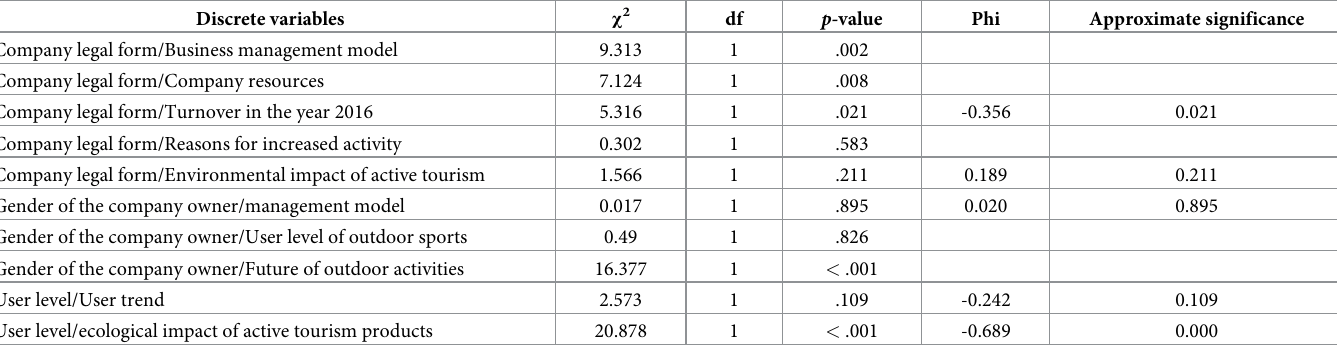
Table 6. Results of the bivariate analysis of the variables from the perspective of the stakeholders offering active tourism in the province of Cordoba. Discrete variables χ